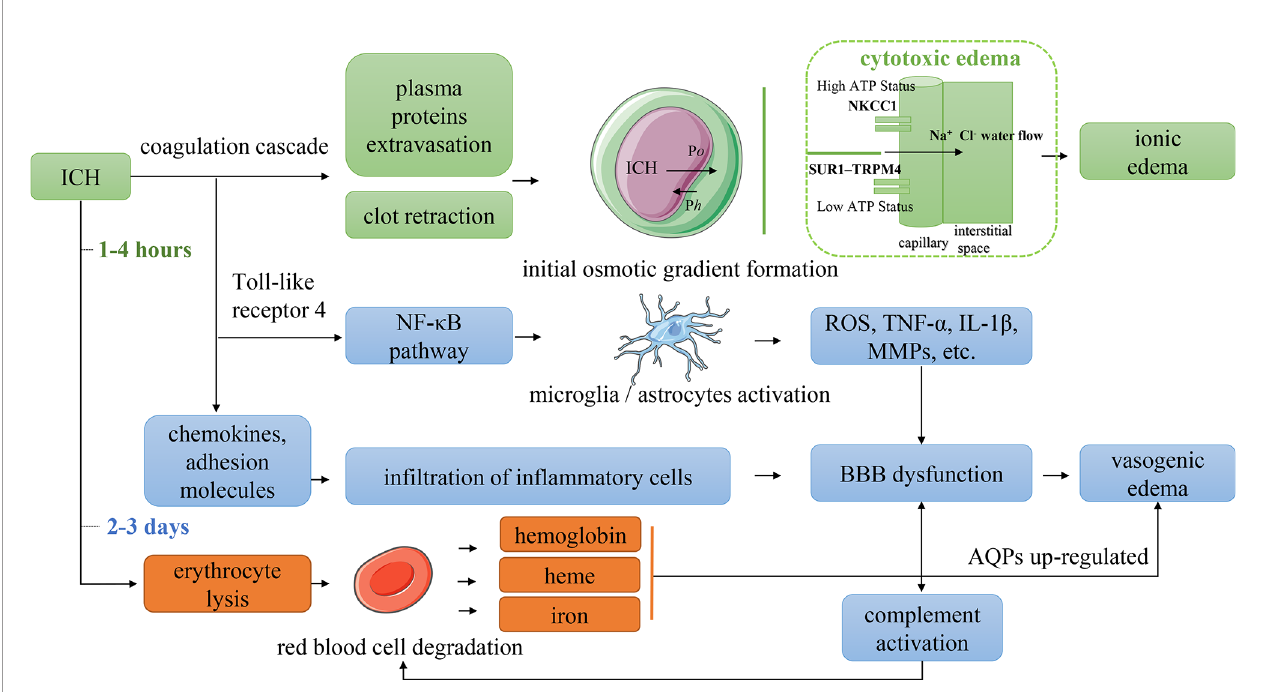
FIGURE 3 | Mechanism of PHE formation. P o indicated the difference in oncotic pressure between the capillaries and interstitial tissue. P h indicated the difference in hydraulic pressure between the capillaries and interstitial tissue. NKCC1, Na – K – Cl cotransporter 1; SUR1 – TRPM4, sulfonylurea receptor 1 – transient receptor potential cation channel subfamily M member 4; ROS, reactive oxygen species; TNF- a , tumor necrosis factor- a ; IL-1 b , interleukin 1 b ; MMPs, matrix metalloproteinases; BBB, blood – brain barrier; AQPs,